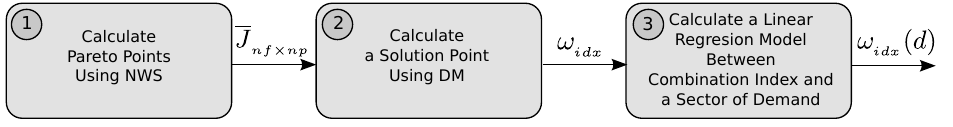
Figure 2. Tuning Strategy Flowchart.